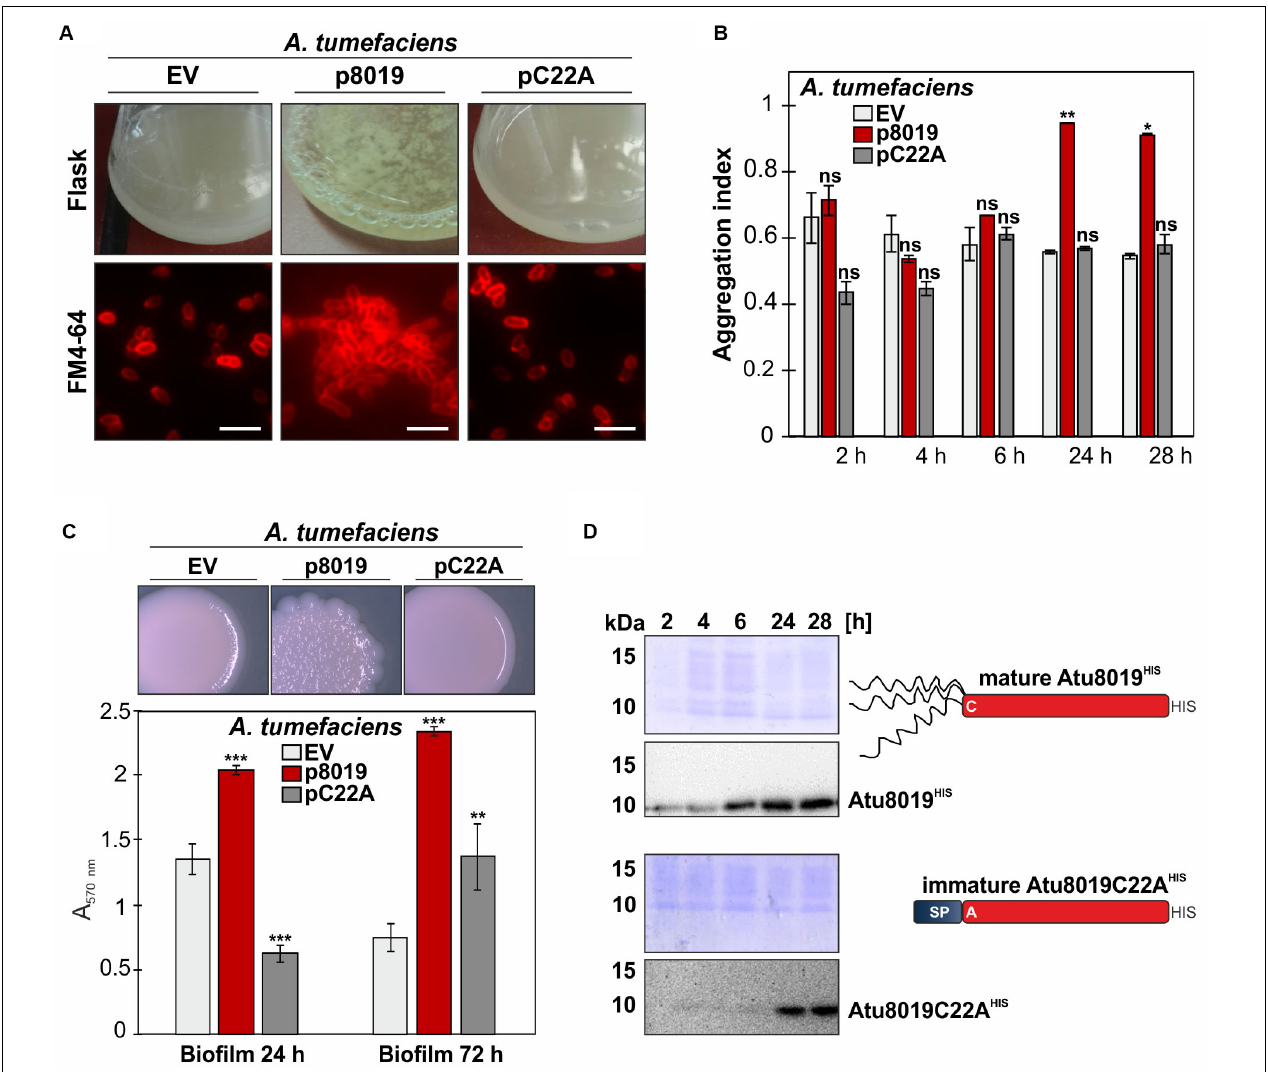
FIGURE 4 | Overproduction of Atu8019 in A. tumefaciens enhances cell clumping and biofilm formation. (A) Enhanced cell aggregation by Atu8019-overproduction in A. tumefaciens . Agrobacterium strains transformed with the empty vector (pTrc200; EV), pTrc-Atu8019 HIS (p8019), or pTrc-Atu8019C22A HIS (pC22A) were cultivated in LB medium supplemented with 0.1 mM IPTG at 30 ◦ C for 24 h. Cells were stained with the membrane dye FM4-64 and visualized by fluorescence microscopy (below). (B) Quantification of cell aggregation. Values are averages of triplicate assays and error bars are standard deviations. (C) Morphology and biofilm formation. Strains were cultivated on LB-agar plates supplemented with IPTG for 4 days before colony morphology was documented (top). Quantitative crystal violet staining biofilm assay at 24 and 72 h (bottom). Values were normalized to culture OD 600 and are averages of quintuplicate assays. Error bars are standard deviations. (D) Verification of protein synthesis by Western blot. The P -values noted a * are less than 0.05, ** are less than 0.01, and *** are less than 0.001. Statistical testing was performed in Excel using T -test with unequal variance and two-tail hypothesis. ns, not